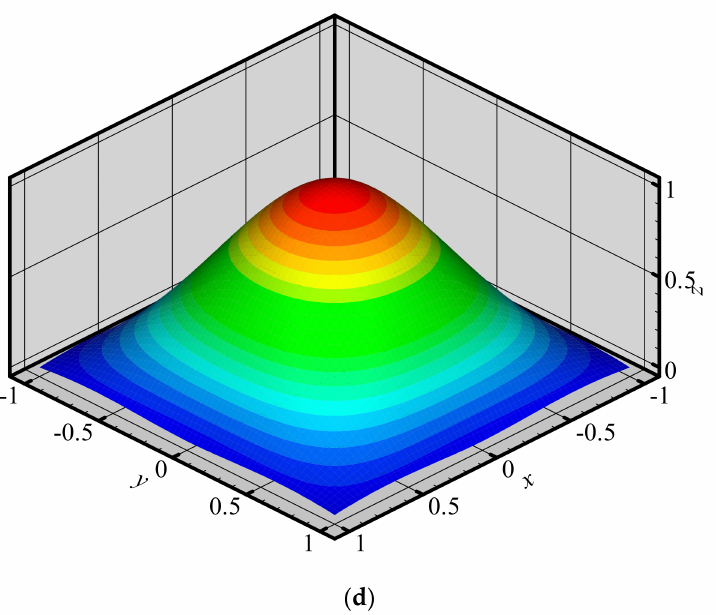
Figure 4. Shape functions of FE − RPIM QUAD4 element for different nodes at different locations: